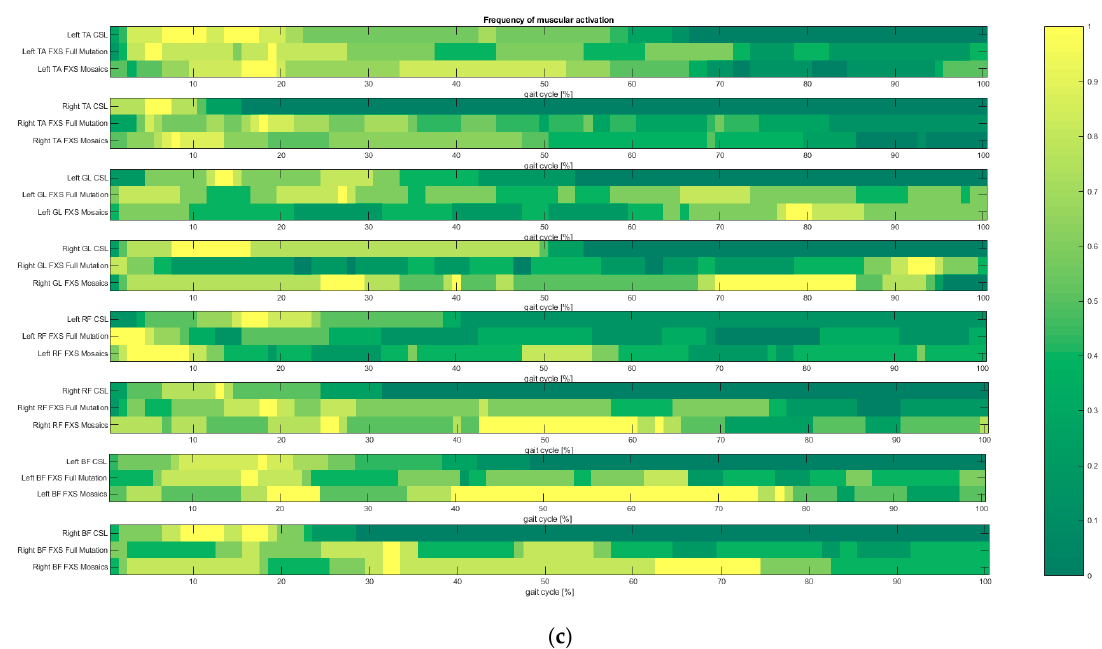
Figure 6. Frequency of muscle activation in analysed muscles in FXS Full Mutation, FXS Mosaics and CS ( a ), CSF ( b ) and CSL ( c ); horizontal bars are colour coded according to the number of subjects in which a muscle activity at each percentage of gait cycle is observed; yellow: muscle activity is detected in all subjects, dark green: muscle is not detected in any subject. Colours refer to the online version of the figure.